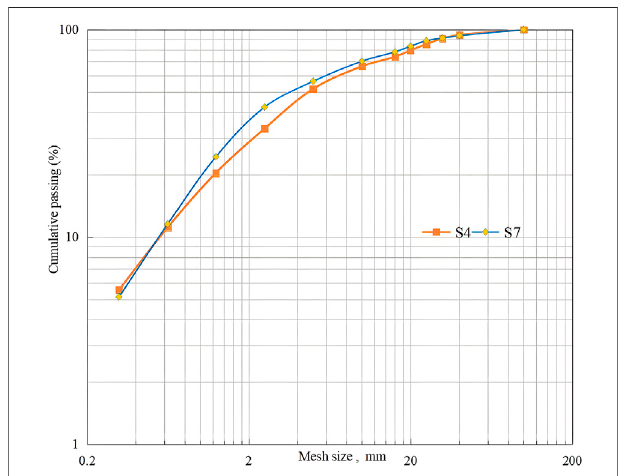
FIGURE 10 | Blasting fragmentation distribution under two loading 20 MPa pressure schemes.